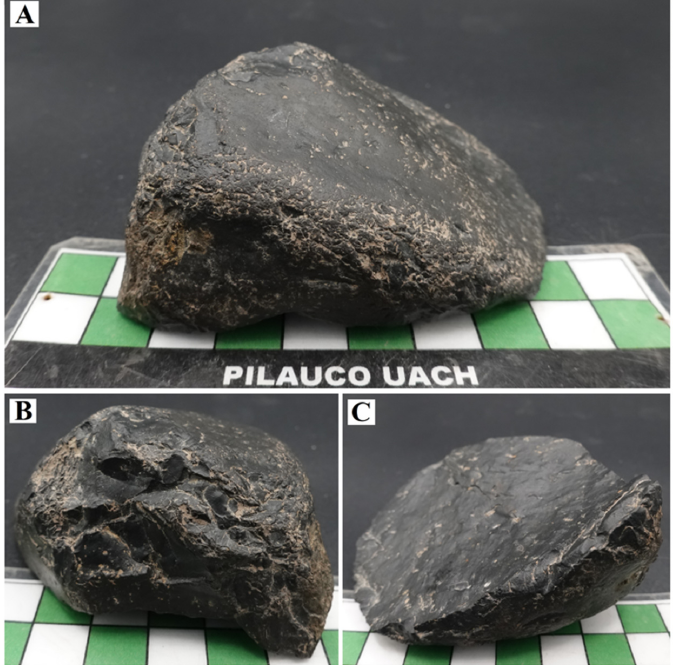
Figure 3. Artifact 15B-P052-010316. Pilauco site, layer PB-7. Typical black dacitic glass. The artifact corresponds to a thick flake from cobble, with an active convex-shaped distal edge, as well as part of the right side. The percussion point is on the left side of the ventral face ( C ). The crescentic marks are 0.2 to 1.5 mm long, and the marks are distributed irregularly only in the cortex ( A , B ). Each white and green square is 1 cm long.